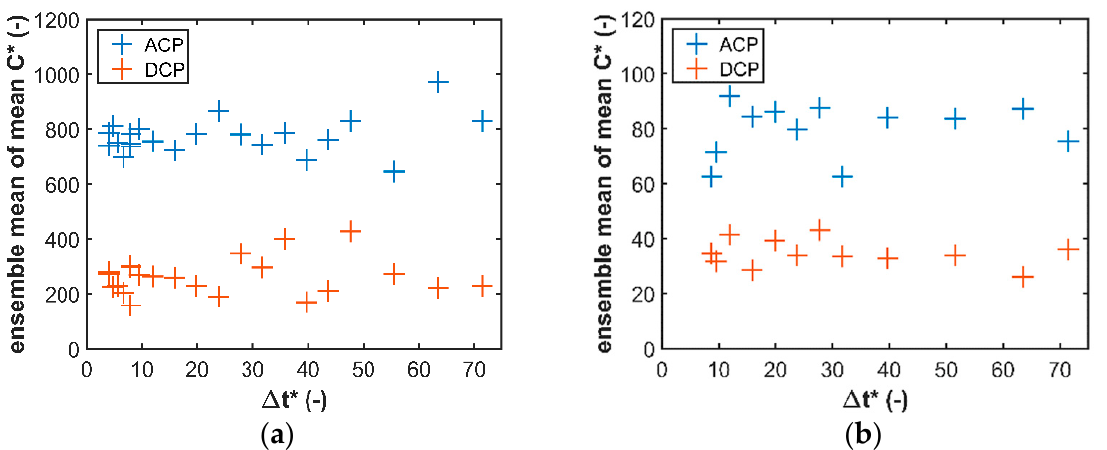
Figure 7. Ensemble mean of mean ACP and DCP for: ( a ) position P; ( b ) position T.